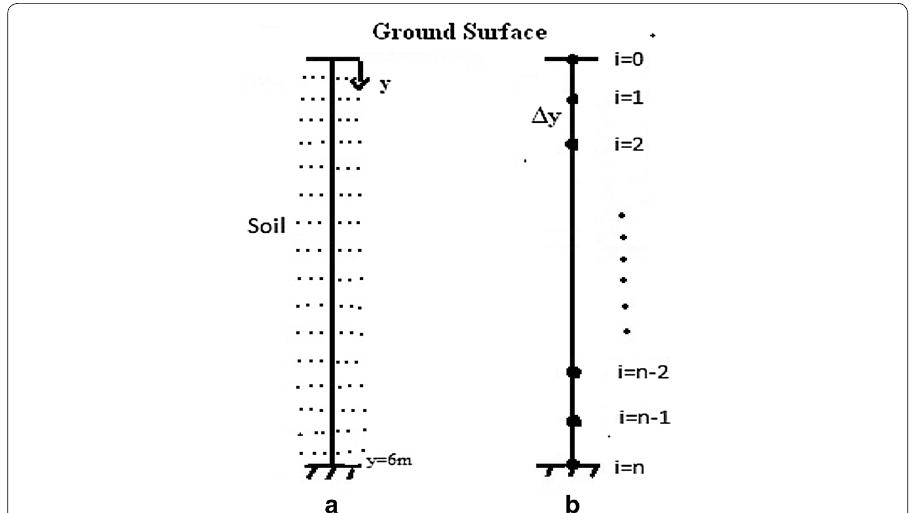
Fig. 1 a Physical model and b computational